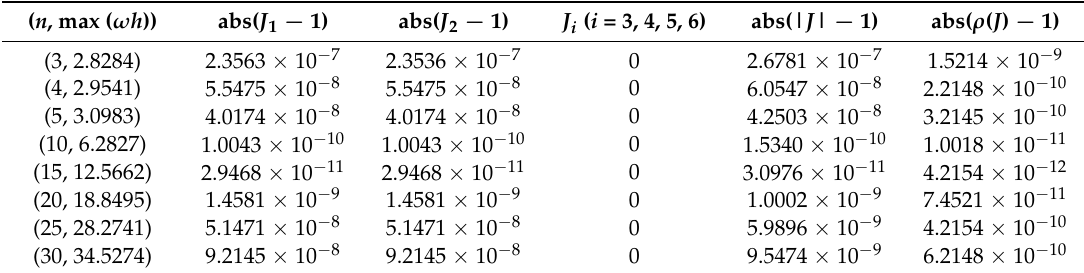
Table 3. The Precisions of J 1 ~ J 6 , | J | and ρ ( J ).